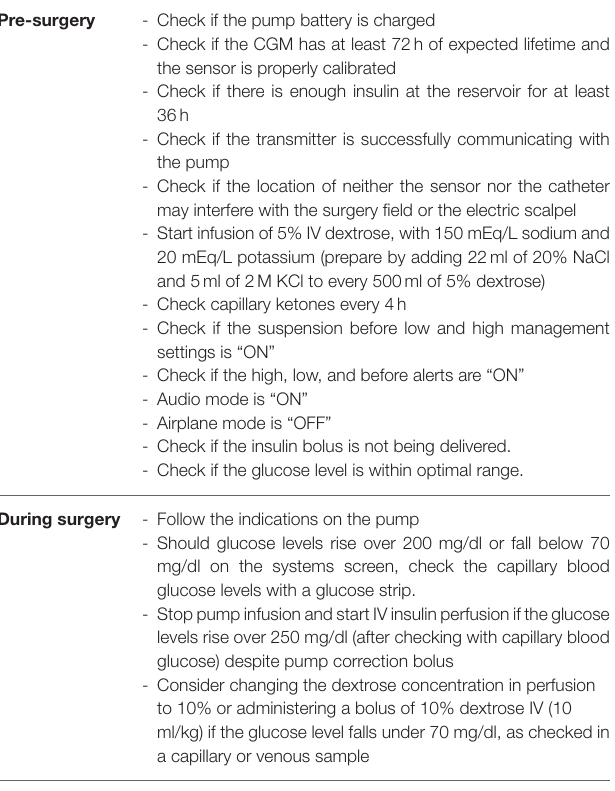
( Figure 2 —laparoscopic appendectomy). Taking together the overnight fast and the surgery, the system infused 20.3 IU/day of insulin, in contrast with the 30.7 IU/day it had infused the day